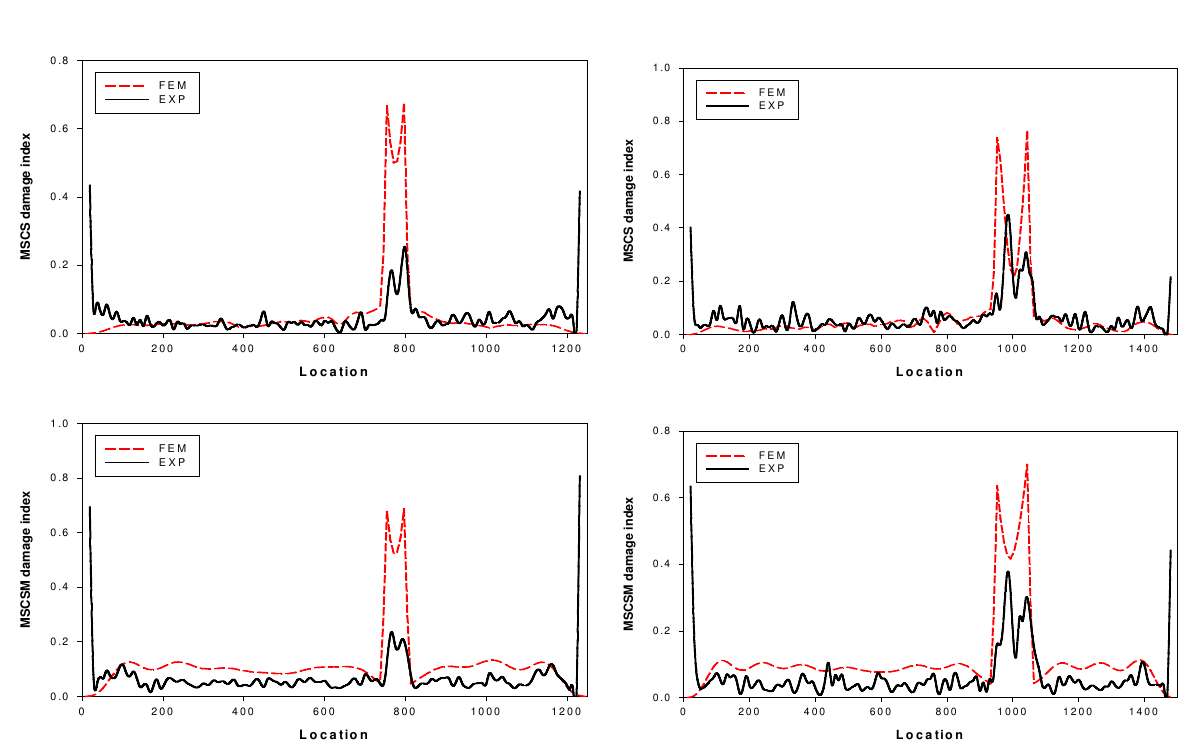
Fig 3. Damage detection methods for beams with FF boundary conditions; Beam1 – left; Beam 2 – right